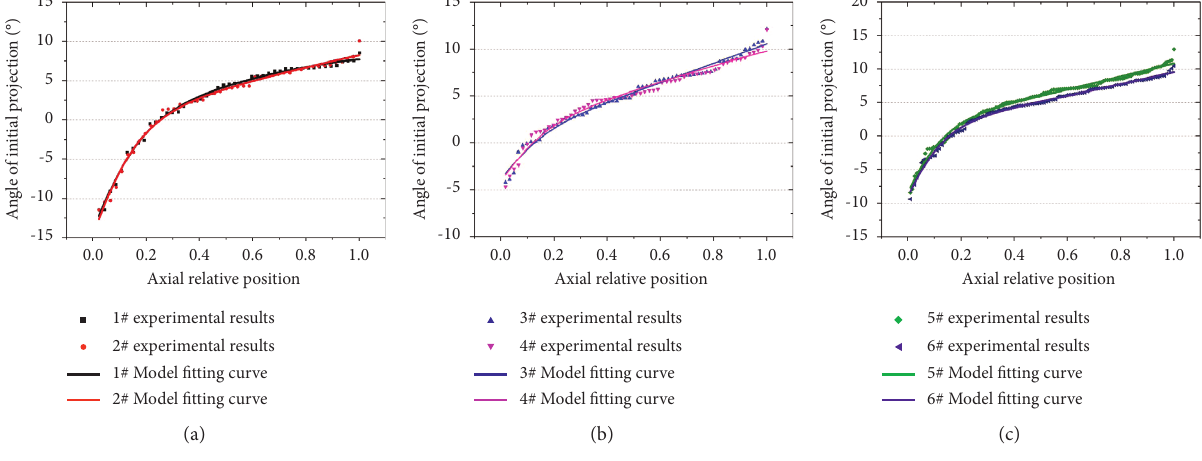
Figure 9: Model fitting curve. (a) 56mm caliber model fitting. (b) 70 mm caliber model fitting. (c) 89mm caliber model